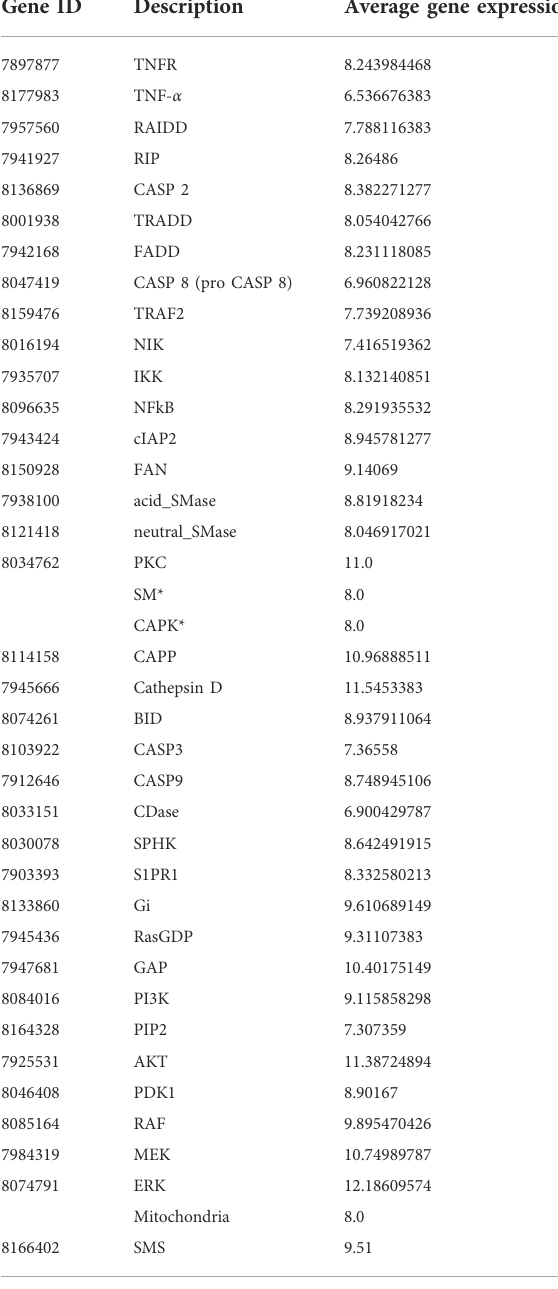
TABLE 3 Average gene expression values of Model Input Entities obtained from the analysis of Microarray Dataset